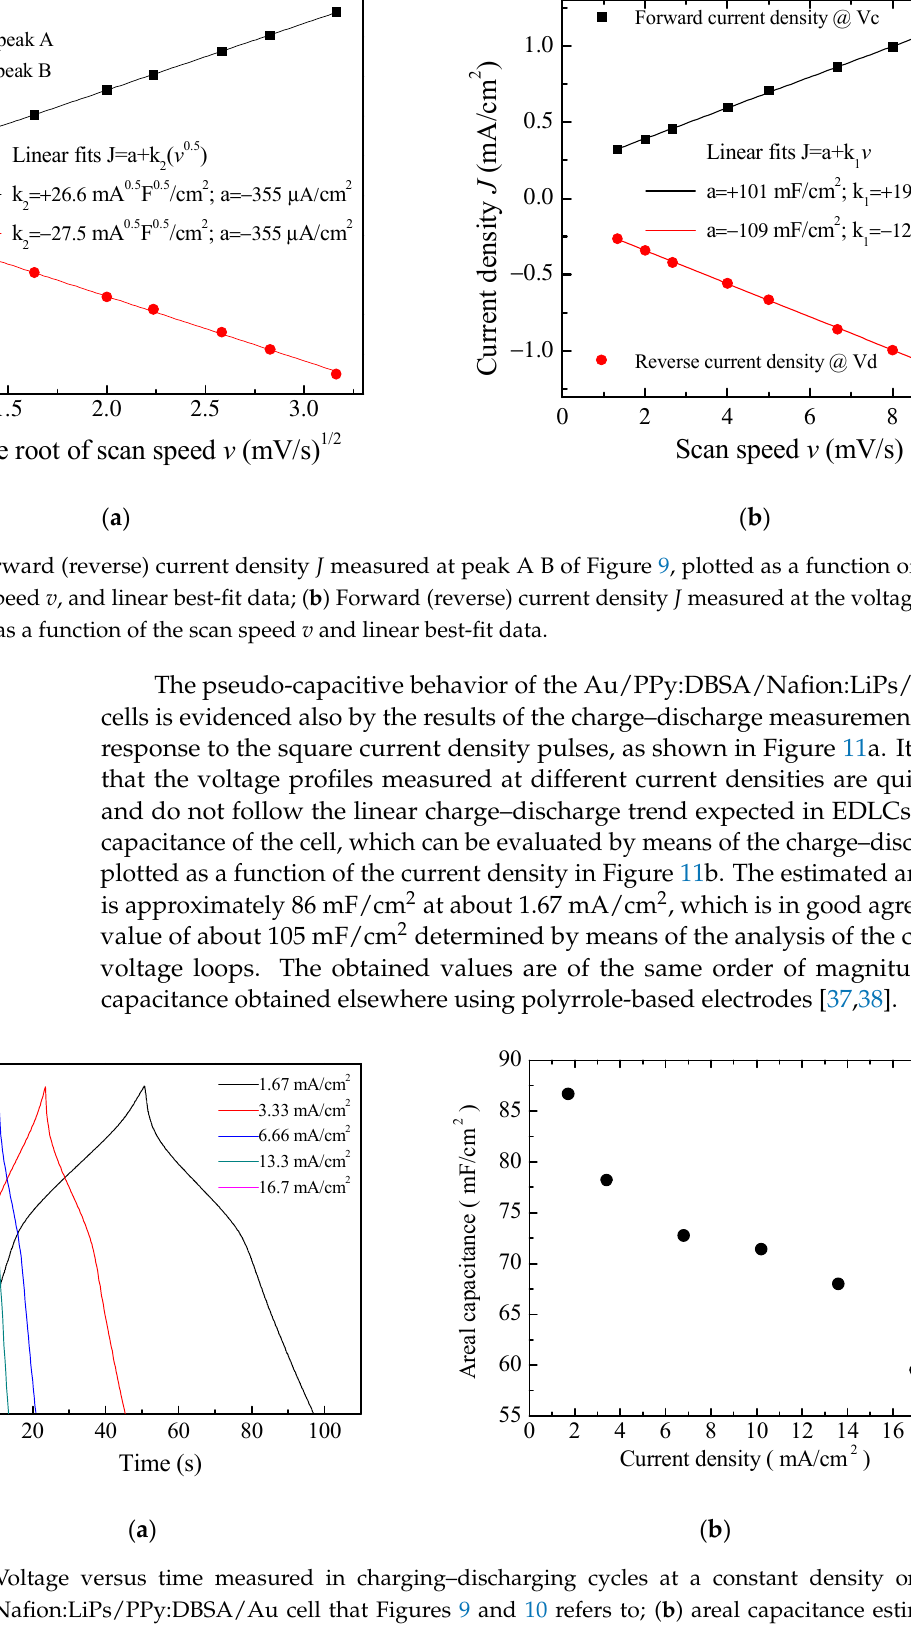
Figure 12a. As expected, the presence of graphene has the effect of increasing the electrode conductivity, as evidenced by the sensitive increase of the current density. In addition, compared to those in Figure 9, the current–voltage loops become closer to the rectangular shape associated with EDLCs with carbon nanostructured electrodes. Nevertheless, a forward and a reverse current density peak identified by the arrows and marked as A and B are broader than those in Figure 9 but are positioned at approximately the same voltage and appear in Figure 12a, meaning that a redox transition involving PPY also occurs in the presence of GNP. While the current density J of peaks A and B in Figure 9 is linearly related